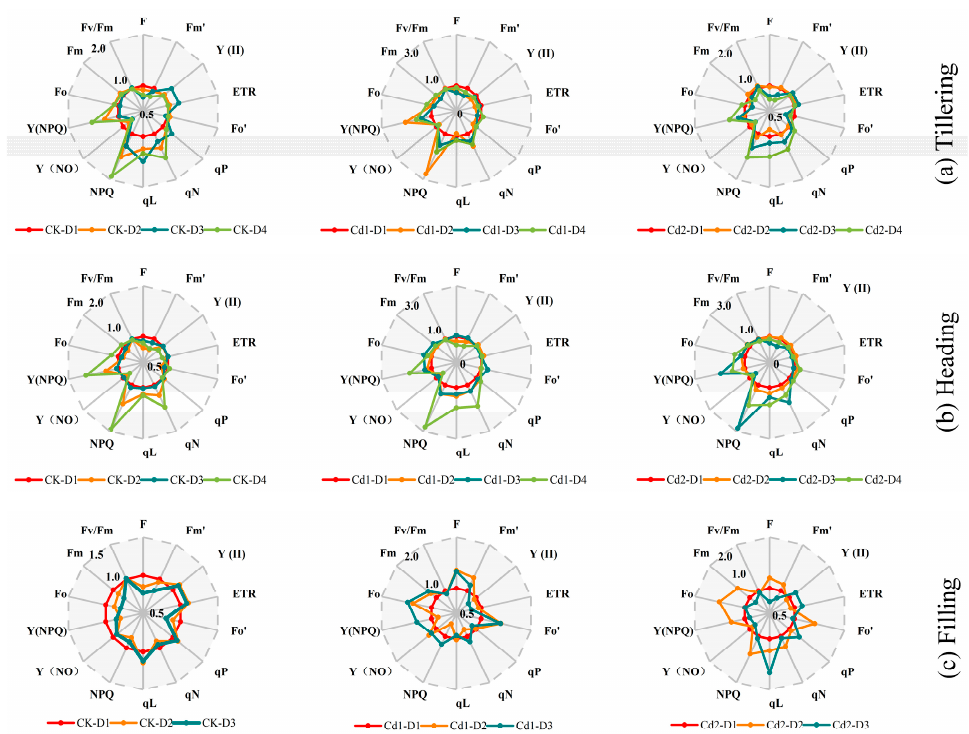
Figure 7. Radar plots of the CK, Cd1, and Cd2 treatment with a series of important parameters derived from the Chlorophyll fluorescence during different growth stages (( a ) Tillering; ( b ) Heading; ( c ) Filling). These parameters for each leaf are the average of all samples with the CK, Cd1, and Cd2 treatment. Taking each leaf at the D1 position as the control (each parameter equals 1, denoted by a red circle) and the parameters of another leaf of the stage are expressed by a fraction relative to the corresponding value of the D1 layer leaf, the number of the outermost circle represents the maximum value of its scale mark. Lines of different colors represent values from D1 to D4.